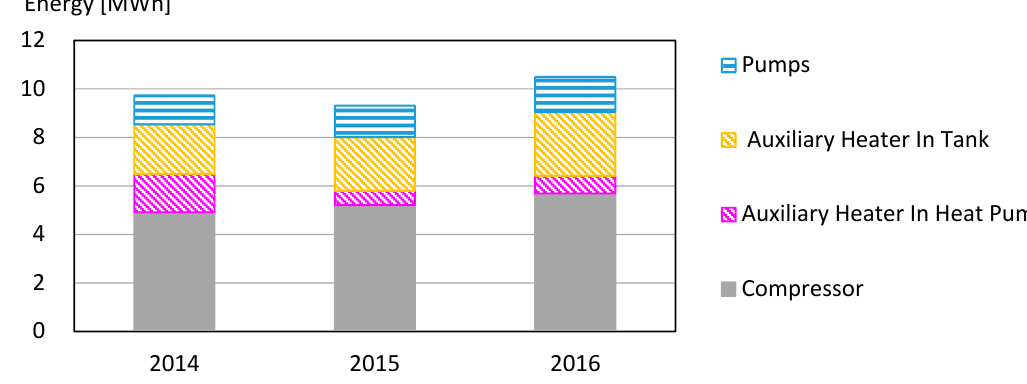
Figure 16. Measured yearly electrical energy consumption of GSHP system components.